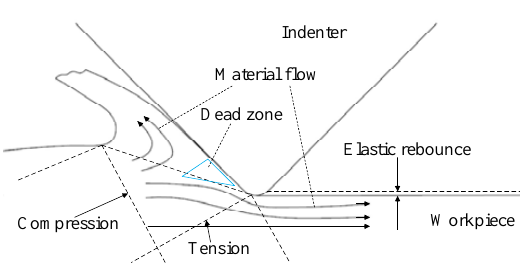
Figure 12. Schematic diagram of the dead zone.